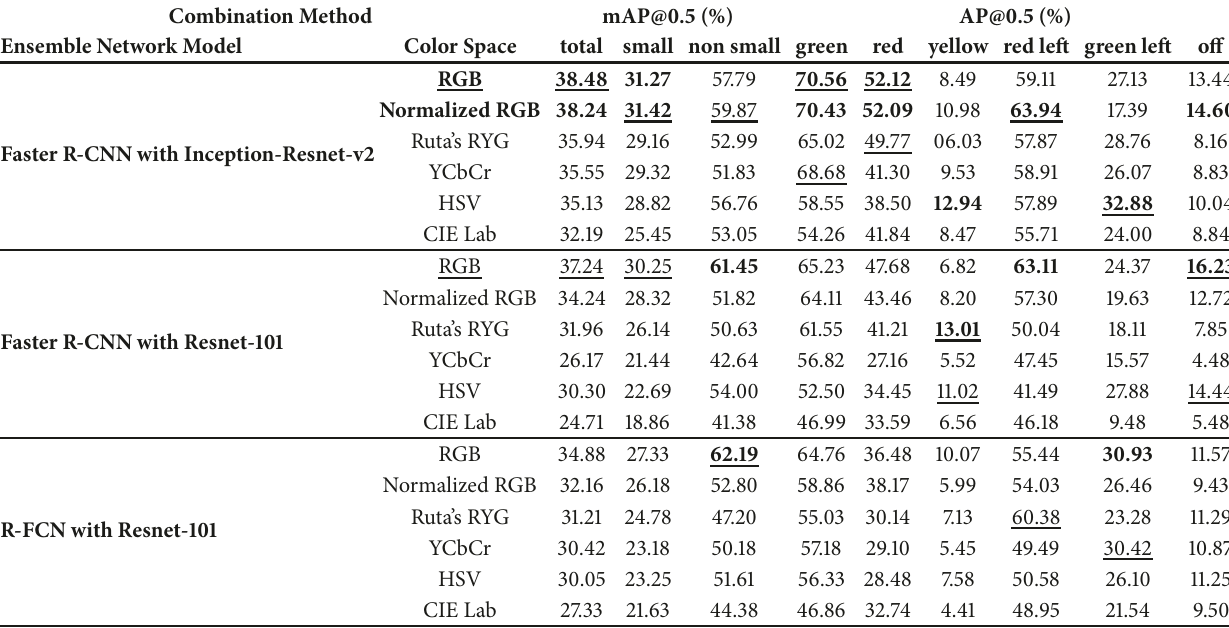
Table 5: Detection performances (mAP@0.5 and AP@0.5) of combination methods on test